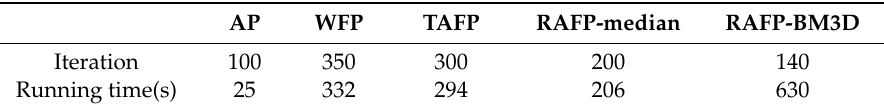
Table 3. Comparison of running time between different algorithms.